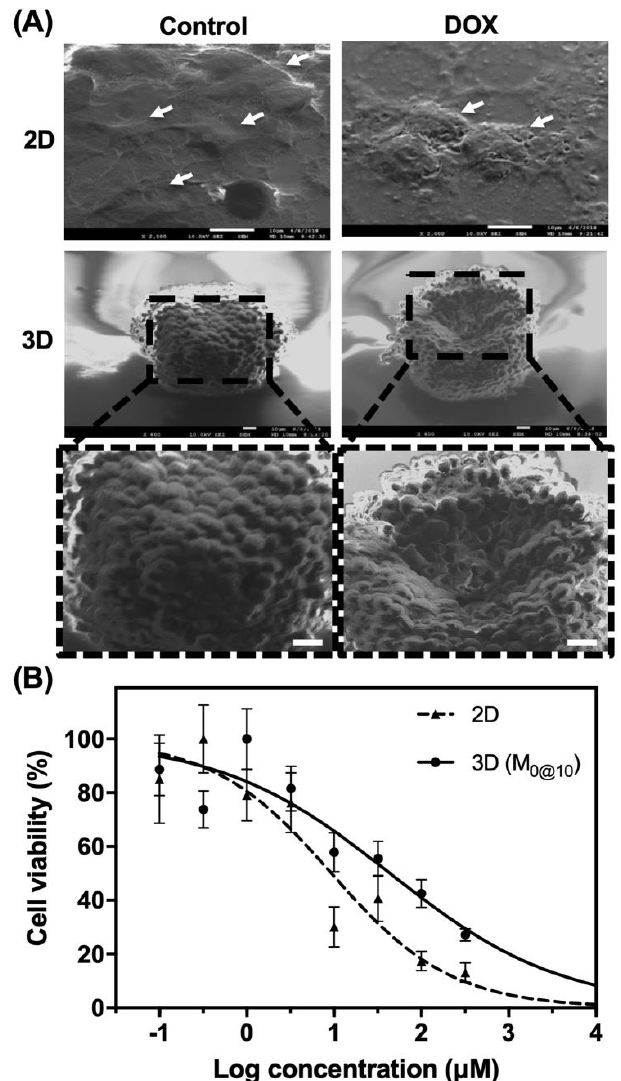
Figure 4. Application of DOX in the 2D condition and with MCAs. ( A ) SEM image of Huh-7 in 2D/3D culture, with / without DOX, cultured for 5 days. ( B ) Dose-response curve of cell viability after treatment with DOX. Scale bars: 10 µm.